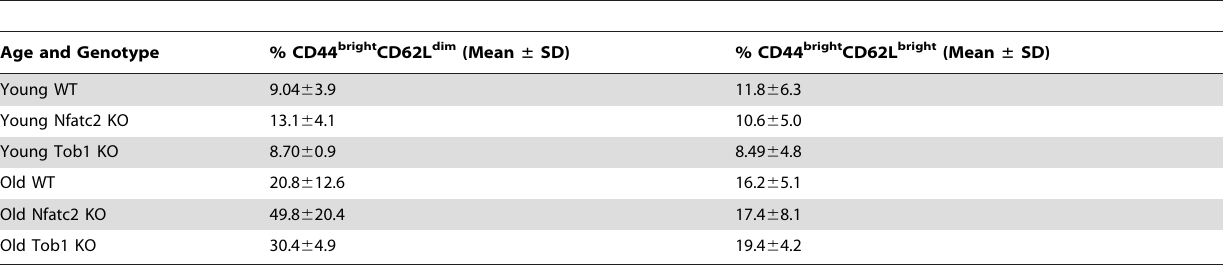
Table 1. Means ( 6 SD) of the percent CD44 bright CD62L dim and CD44 bright CD62L bright for WT, Nfatc2 KO, and Tob1 KO T cells from young and old